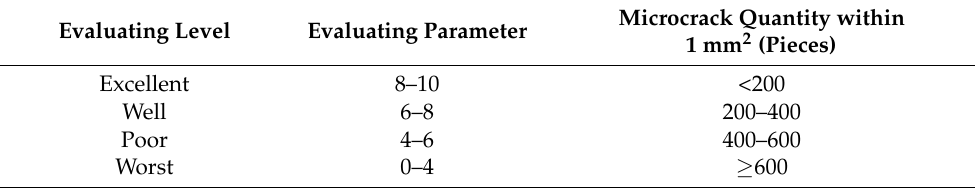
Table 7. Evaluation basis for surface microcrack